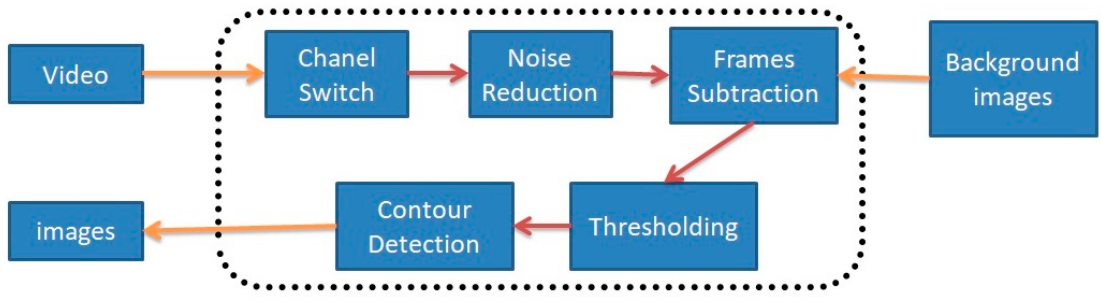
Figure 2. Motion- and object-tracking algorithm diagram .